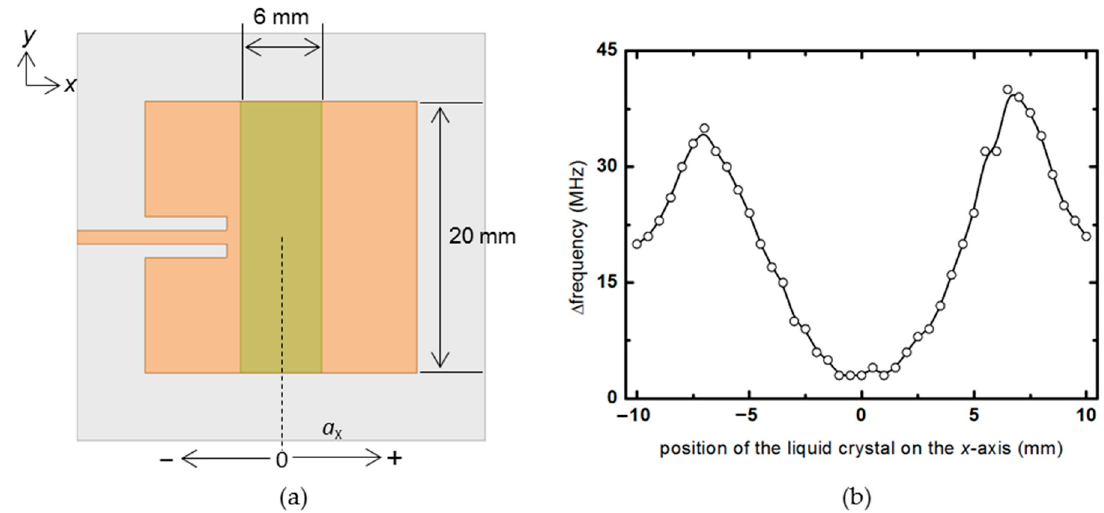
Figure 6. ( a ) Top view of the patch antenna showing the liquid crystal moving in the x -axis. ( b ) Frequency change rate according to the position of the liquid crystal in the x -direction.